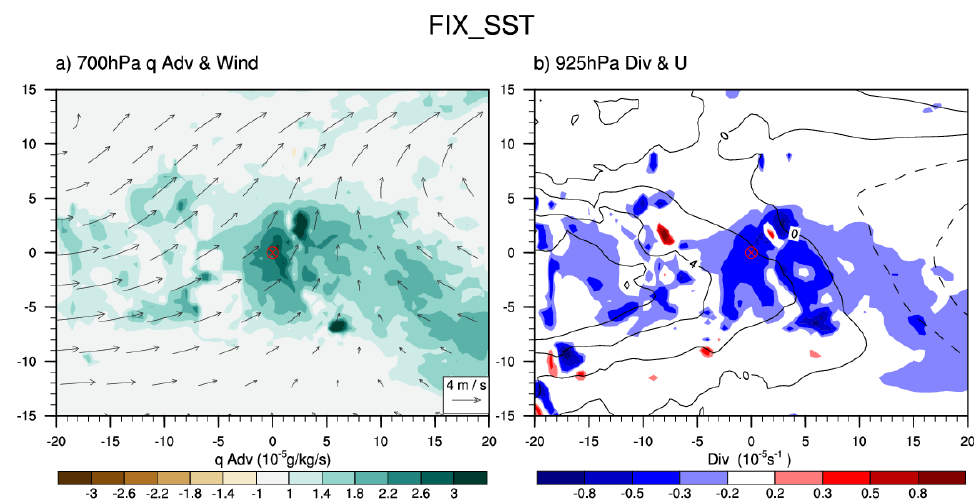
Figure 7. Composite horizontal patterns of ( a ) lower-tropospheric (700 hPa) moisture advection (shading; 10 − 5 g/kg/s) and wind (vector; ms − 1 ) fields and ( b ) boundary-layer (925 hPa) divergence (shading; 10 − 5 s − 1 ) and zonal wind (contour; ms − 1 ) fields in the FIX_SST experiments. The red circles represent the composite reference rainfall centers.